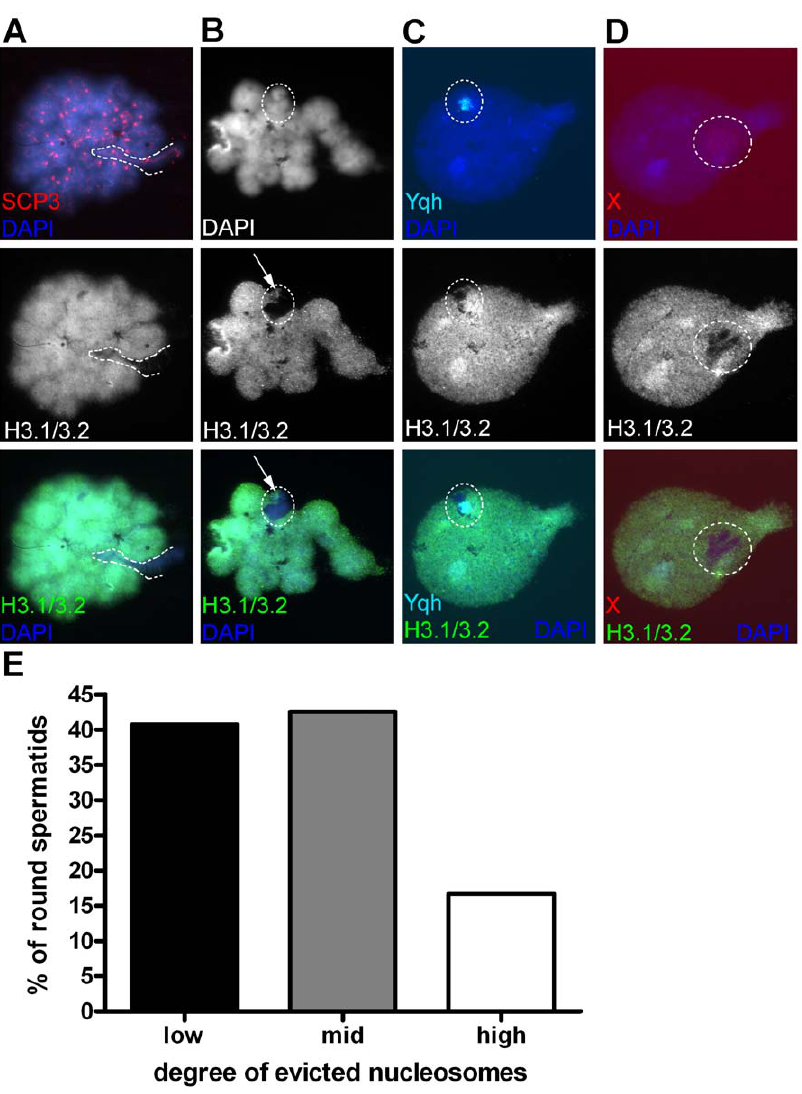
Figure 7. Transmission of incompletely evicted sex chromatin to round spermatids. A Metaphase I spermatocyte with a high degree of XY bivalent H3.1/3.2 nucleosome eviction. A bulge of H3.1/3.2 (arrow) was present in a more intense DAPI domain that is part of the encircled